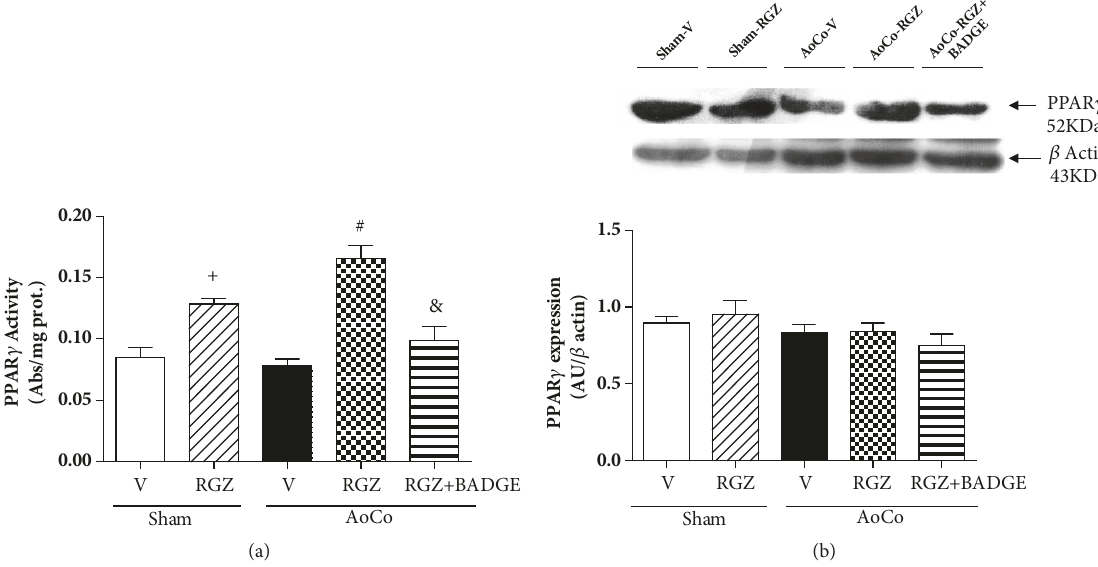
Figure 8: Effect of rosiglitazone (RGZ) on PPAR 𝛾 activity (a) and PPAR 𝛾 expression of sham or aortic coarctated (AoCo) rats treated with vehicle (V), rosiglitazone (5mg/kg, RGZ), or RGZ + bisphenol A diglycidyl ether (120 mg/kg, RGZ+BADGE). PPAR 𝛾 activity was evaluatedusing a transcription factor assay kit (Cayman Chemicals, Ann Arbor, MI, USA). Westernblot image is representative of 6 different experiments. Bars represent the mean ± SEM (n=6 animals of group). One-way analysis of variance (ANOVA) post Tukey. + P < 0.05 Sham-V vs. Sham-RGZ, # P < 0.05 AoCo-V vs. AoCo-RGZ, and & P < 0.05 AoCo-RGZ vs. AoCo-RGZ+BADGE.